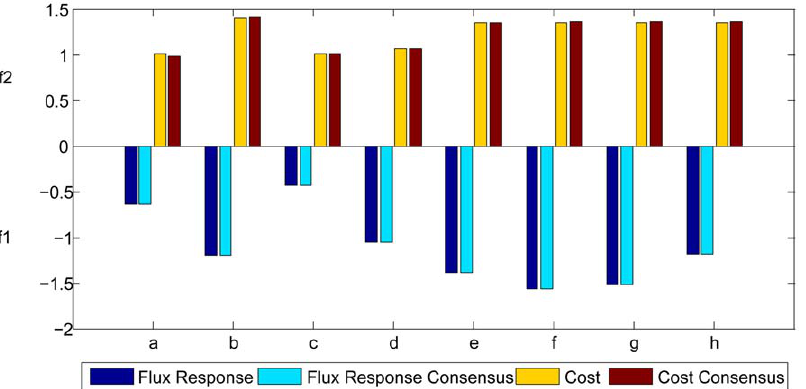
Figure 8. Cross-course comparison. Flux response ( f 1 ) and cost ( f 2 ) for the different courses evaluated with their optimal parameters (in dark blue and yellow) and with the consensus set of parameters (in light blue and brown).